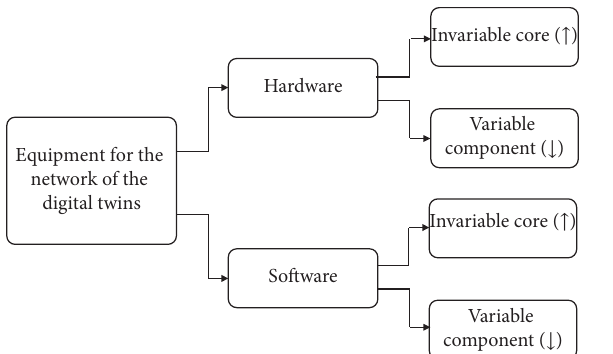
Figure 8: Decomposition of equipment for the network of digital